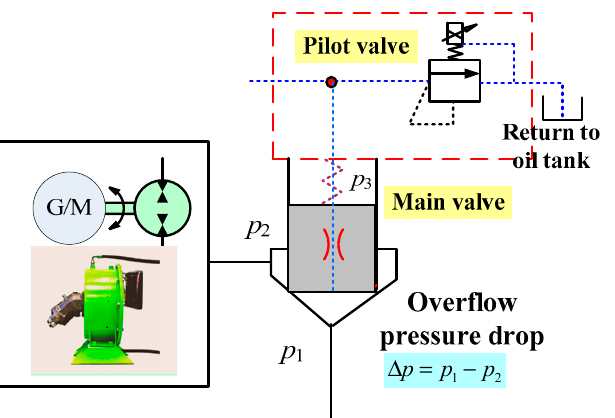
Figure 3. The schematic diagram of electric energy recovery system for proportional relief valve.